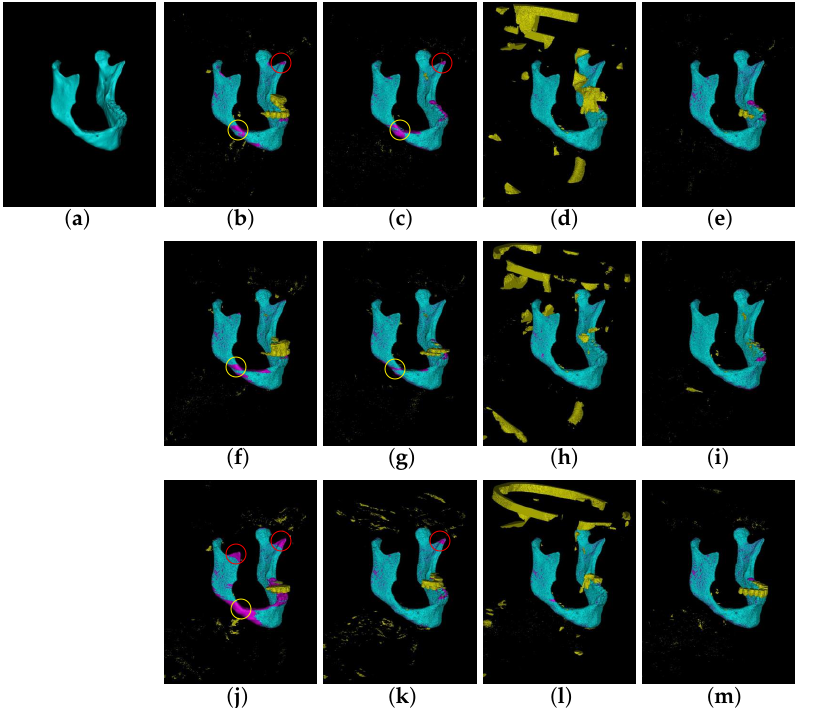
Figure 3. 3D view of a case from the UMCG head and neck dataset. ( a – m ) Ground truth, 2D U-Net, 2.5D U-Net, 3D U-Net, RUnetSeg, 2D SegU-Net, 2.5D SegU-Net, 3D U-Net, RSegUnetSeg, 2D Att U-Net, 2.5D Att U-Net, 3D Att U-Net, and RAttUnetSeg. We use cyan to indicate the correctly segmented mandible compared to the ground truth. Pink represents the regions that were missed by the algorithms, while yellow indicates the segmented regions that are not the mandible. The red circles indicate the coronoids of the mandibles that are often missed by the traditional EDCNNs, and the yellow circles indicate parts of the mandible